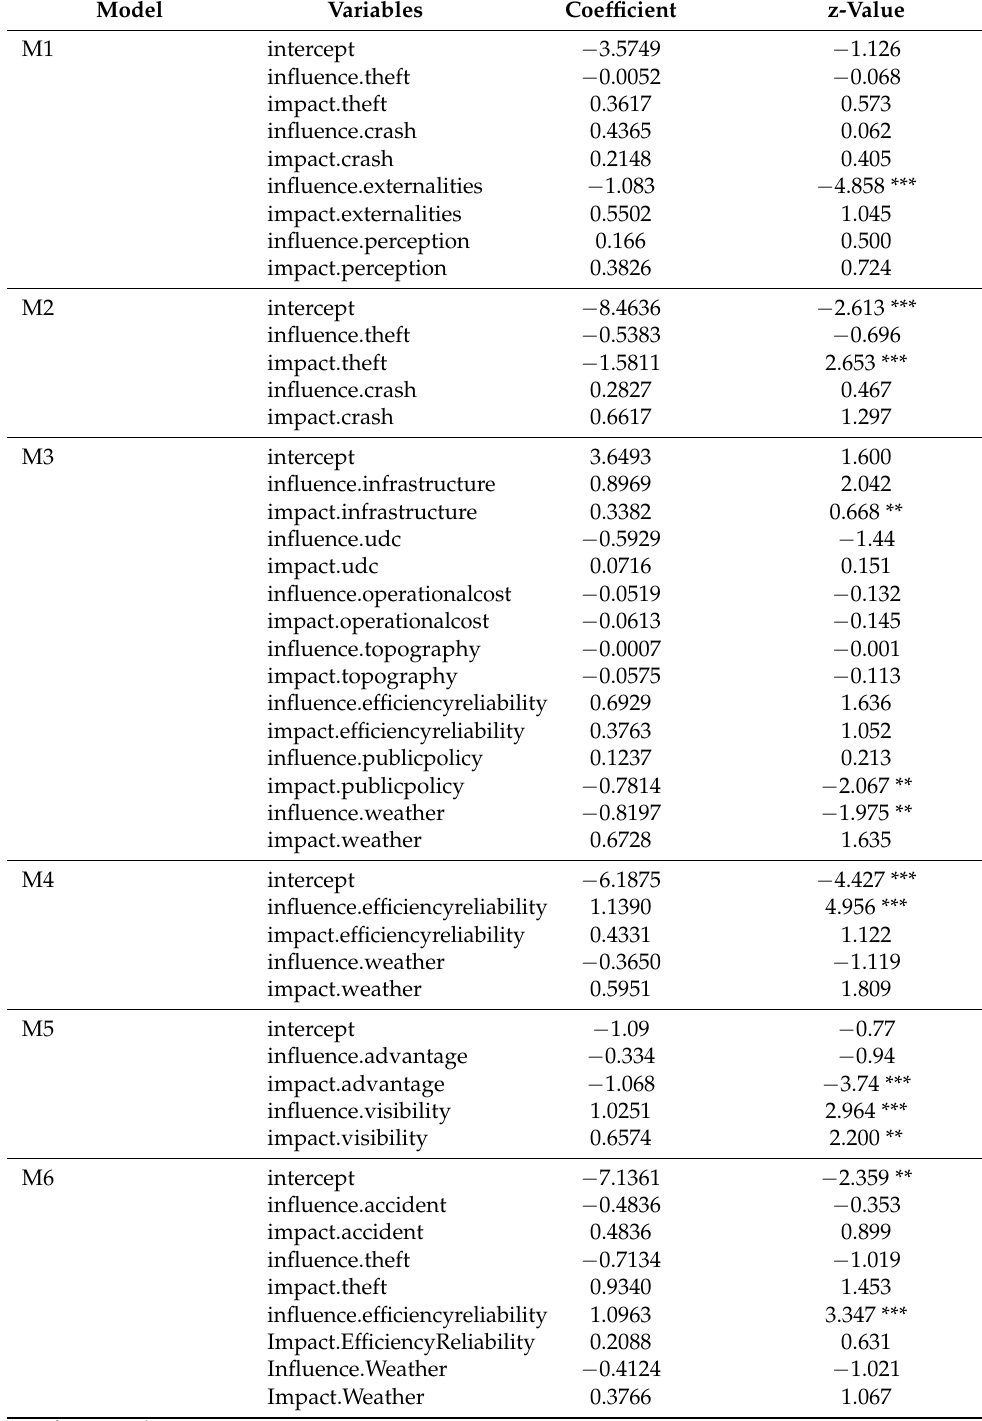
Table 3. Measured behavioural